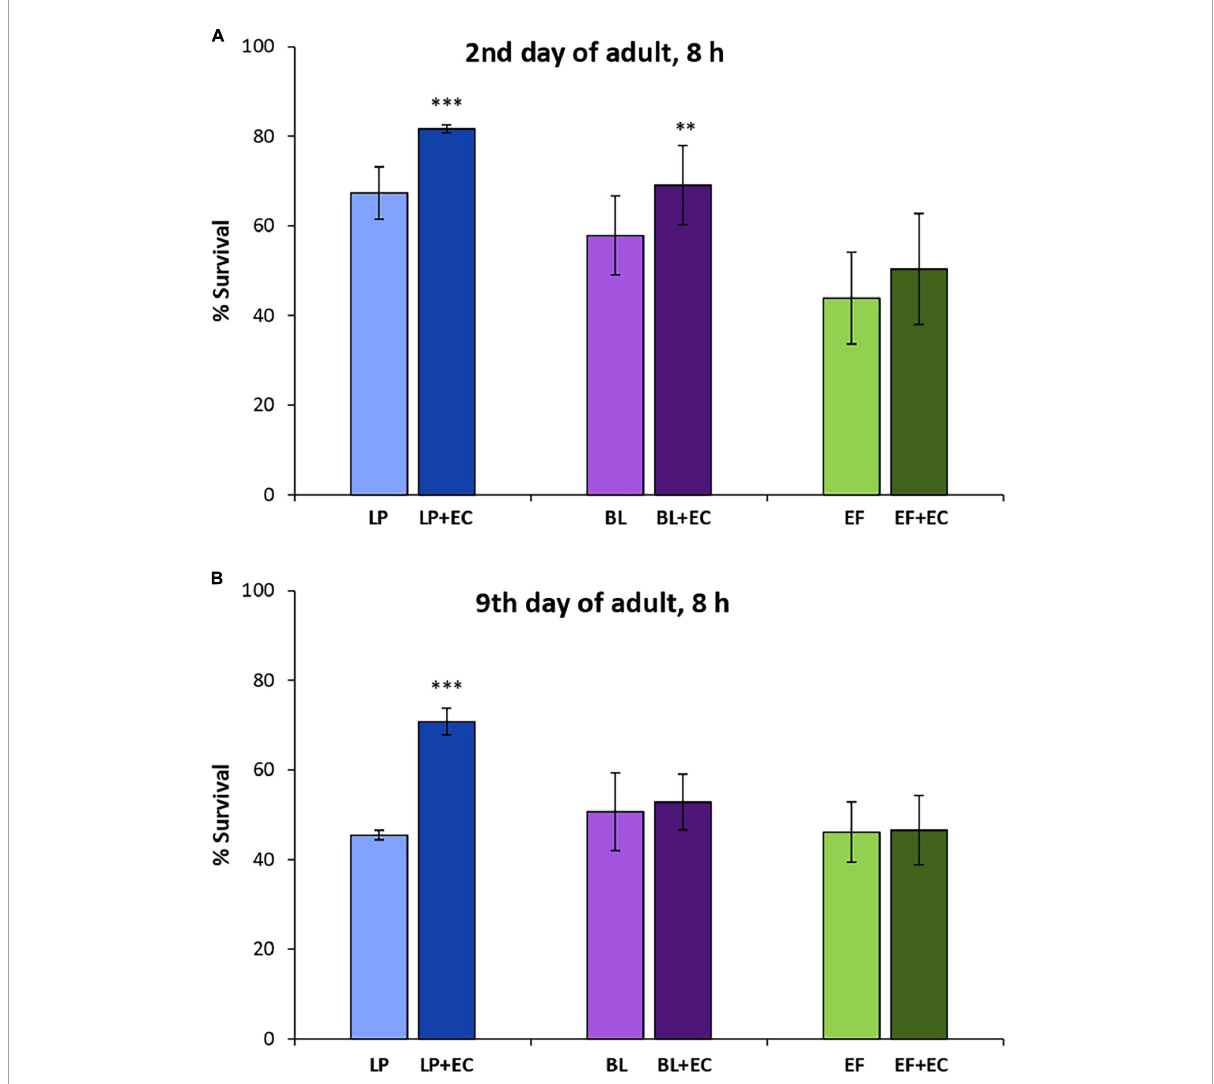
FIGURE4 Survival rates of N2 wild type C. elegans after being submitted to thermal stress (35 ◦ C, 8 h) applied at days 2 (A) or 9 of adulthood (B) following cultivation with and without epicatechin (EC, 200 µ M) in the presence of Lactobacillus plantarum CLC17 (LP), Bifidobacterium longum NCIMB 8809 (BL) or Enterococcus faecium CECT 410 (EF). Differences between worms grown without and with EC were calculated for each strain using the Chi-Square Test. The differences were considered significant at *** p < 0.001 and ** p <